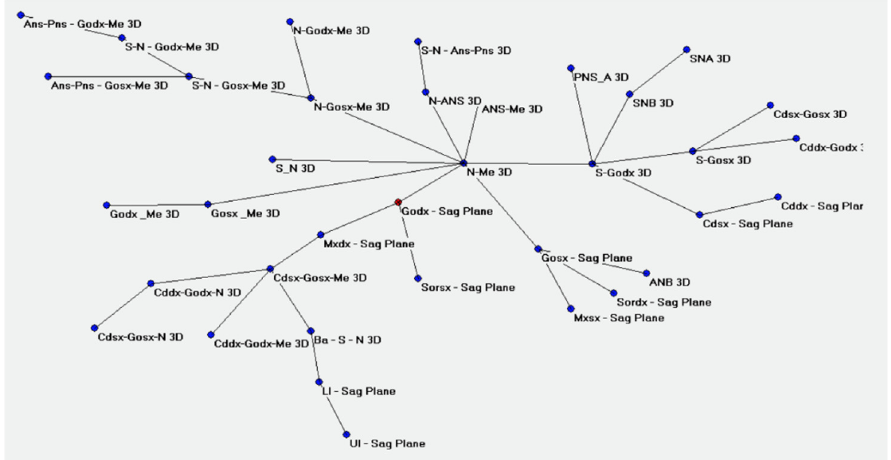
Figure 2. Right go-sagittal plane betweenness centrality displayed on Pajek.